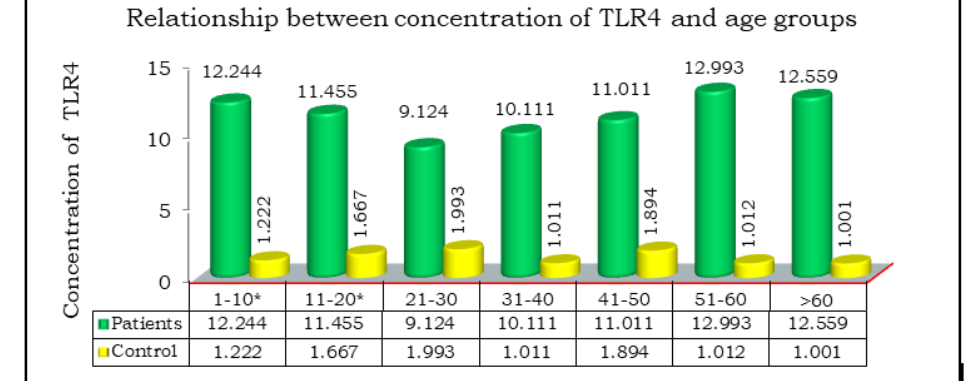
Fig. 9. The levels of TLR4 concentration according to patients with pneumonia and control age groups